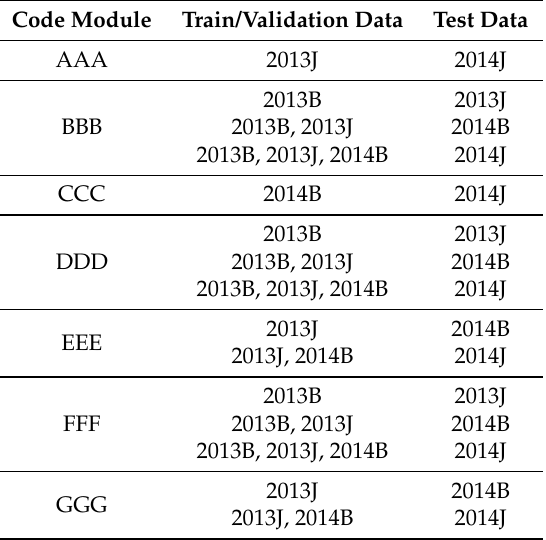
Table 1. Summary of the